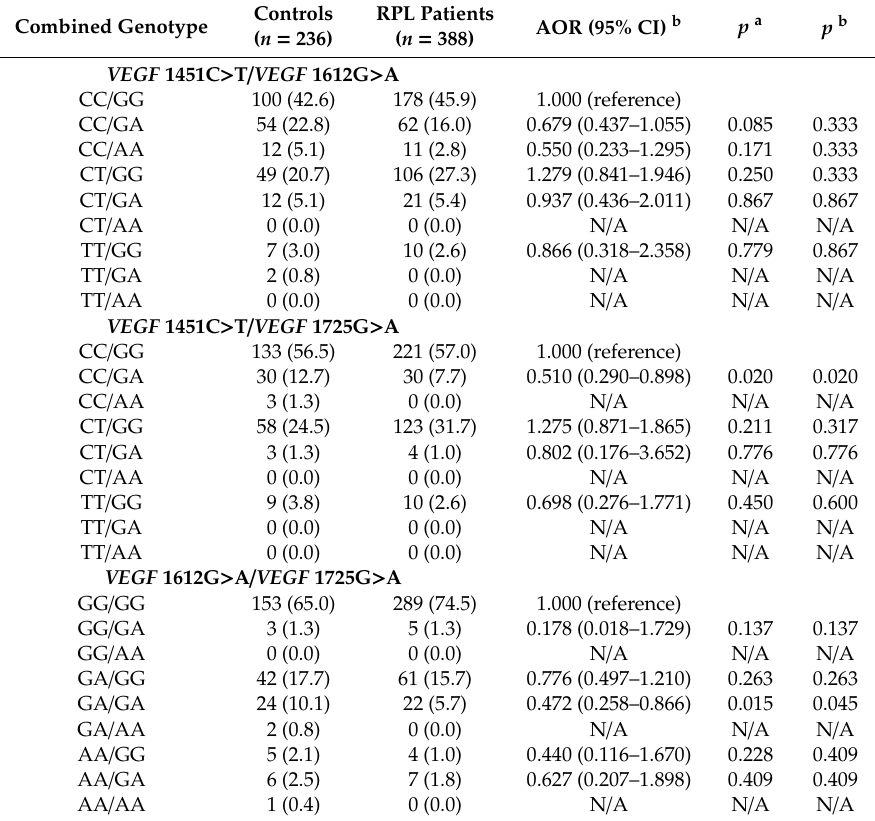
Table 4. Combined genotype analysis for the VEGF polymorphisms 1451C > T, 1612G > A, and 1725G > A in RPL patients and